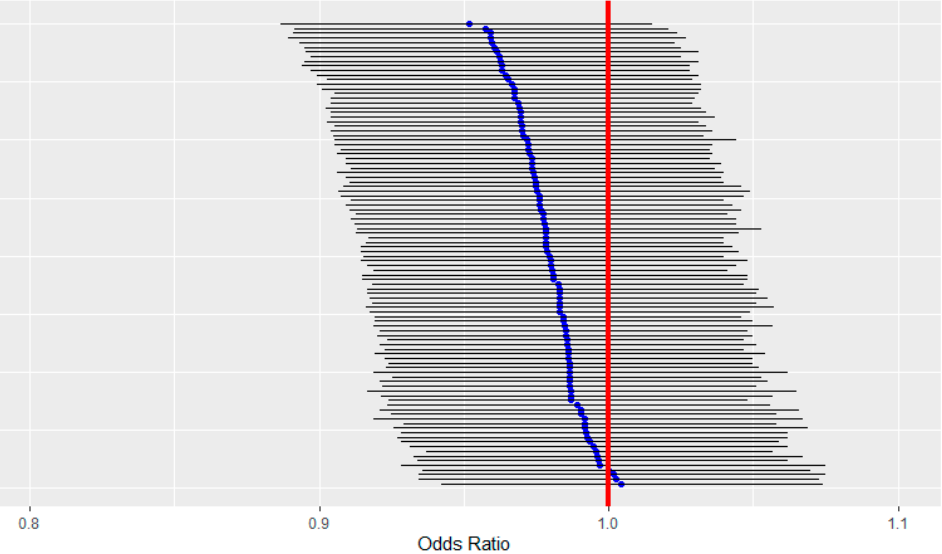
Int. J. Environ. Res. Public Health 2023 , 20 , x FOR PEER REVIEW Figure 3. Neighborhood deprivation index odds ratio estimates in the blue circles and 95% credible intervals in black lines for each of the 100 simulated datasets from the first sampling scheme for participants.